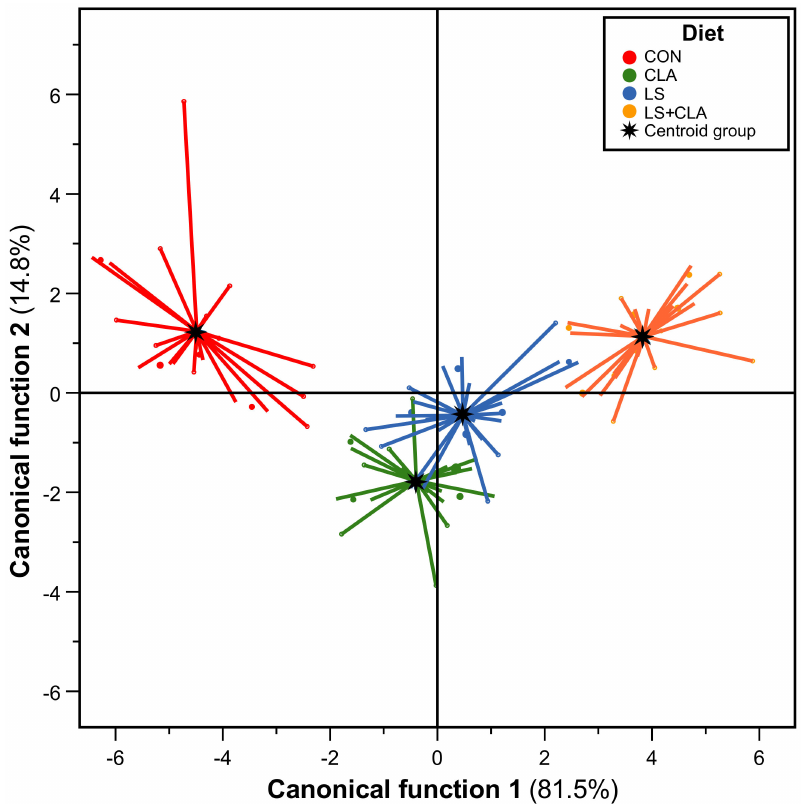
Figure 6. Graphic representation of the fat samples from young Holstein bulls fed with the four different diets (CON, LS, CLA, and LS+CLA) according to stepwise discriminate analysis including spectra of fat samples. Lines connect each sample with group centroid. Range selected from 3000 to 1000 cm − 1